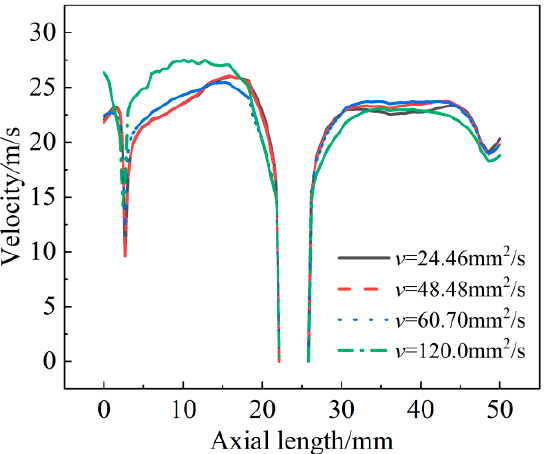
Figure 13. Velocity profile in the impeller of the HAMP with different liquid viscosities under critical cavitation condition ( Δ = 3%).